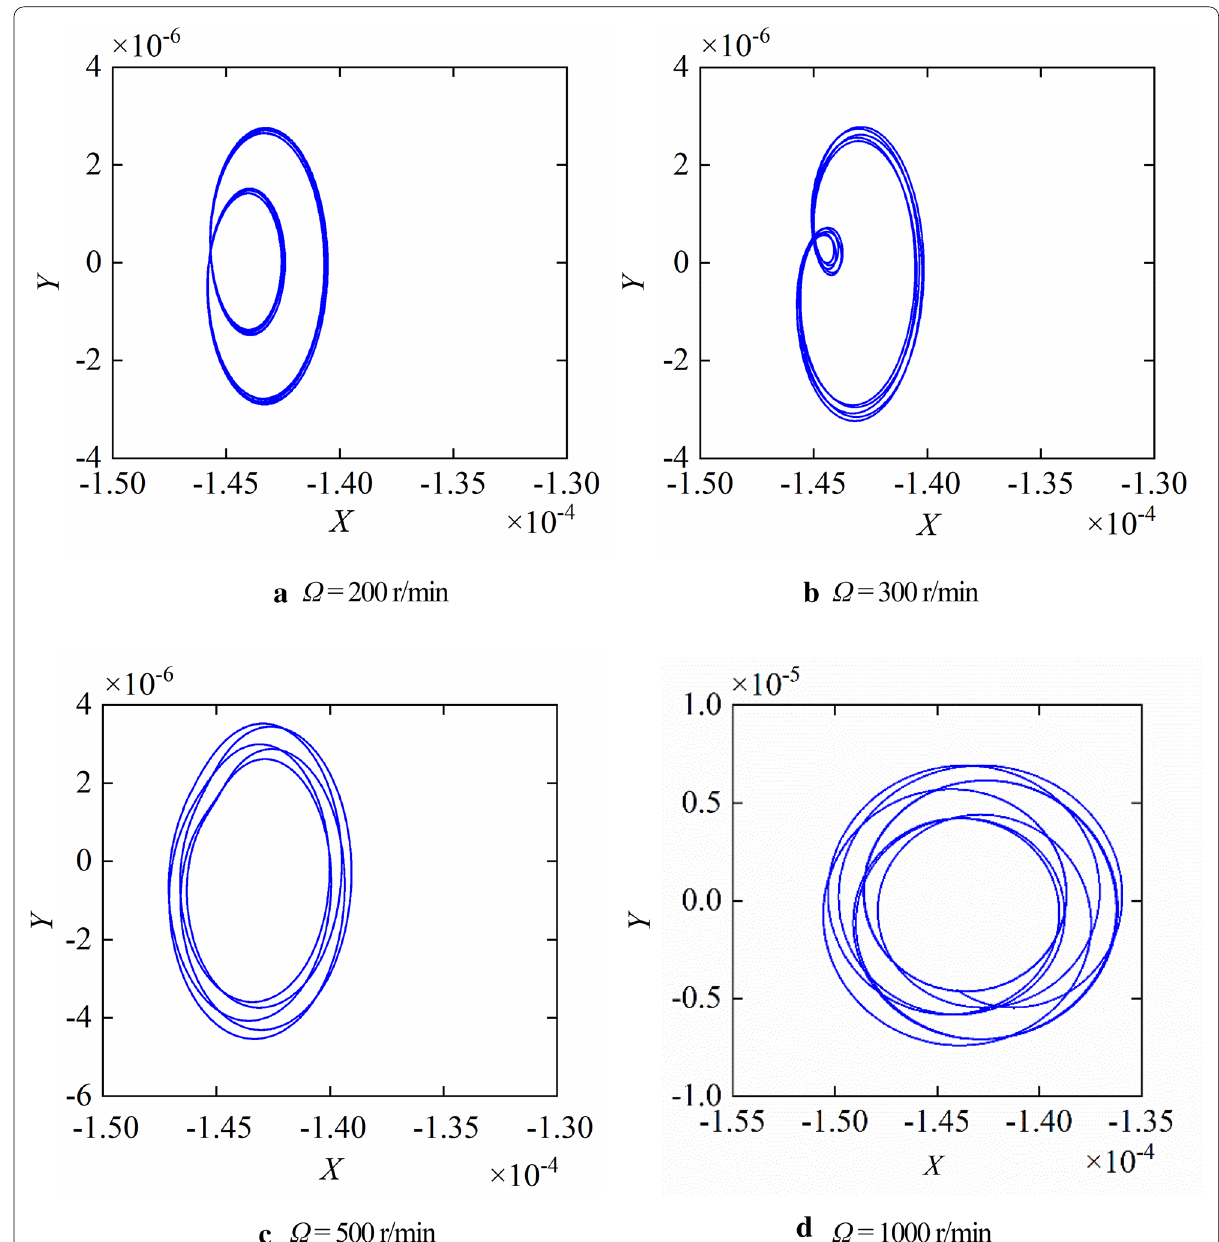
Figure 7 Shaft orbit of rotor system with a slant crack based fractional damping (under the different rotating speed)